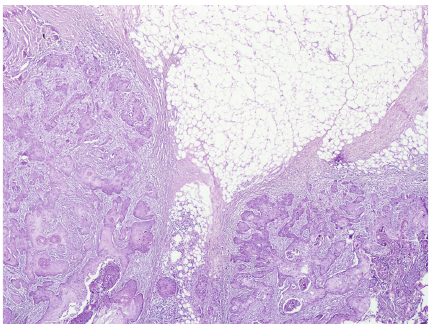
Figure 2: (H&E × 40) Focal keratin pearls and invasive squamous epithelial cluster containing a single cell keratinization.